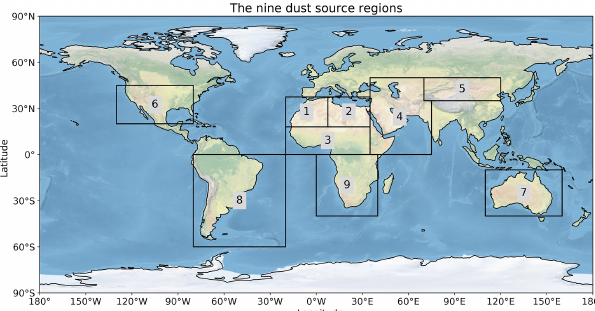
Figure 1. Coordinates of the nine main source regions used in this study. The nine source regions are (1) western North Africa, (2) eastern North Africa, (3) the southern Sahara and Sahel, (4) the Middle East and central Asia (which includes the Horn of Africa), (5) East Asia, (6) North America, (7) Australia, (8) South Amer- ica, and (9) southern Africa. Exact coordinates for these regions are given in Kok et al. (2021a). After Kok et al. (2021a); made with Natural